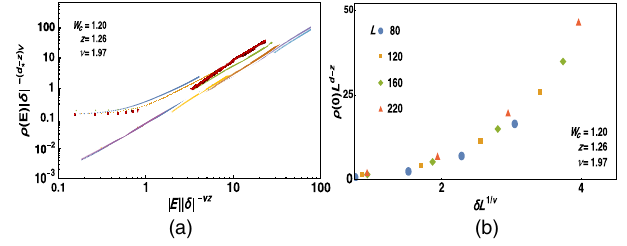
FIG. 8. (a) Collapse of average DOS at finite energy (obtained in system with L ¼ 220 ) across the multicritical point shown in Fig. 2 (left). All data collapse reasonably well onto two branches corresponding to anisotropic semimetal (upper branch) and metallic phase (lower branch), which tend to meet in the critical regime. (b) Data collapse of average DOS at zero energy for different system sizes inside the metallic phase, appearing across the MCP. These two data collapses are obtained with numerically extracted critical exponents z ¼ 1 . 26 and ν ¼ 1 . 97 (see Fig. 7), with d ¼ 5 = 2 (cid:4)